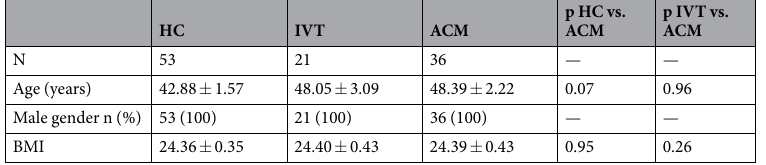
Table 1. Baseline characteristics of enrolled subjects. HC, Healthy Control subjects; IVT, patients affected by Idiopathic Ventricular Tachycardia; ACM, patients affected by Arrhythmogenic CardioMyopathy; BMI, Body Mass Index.